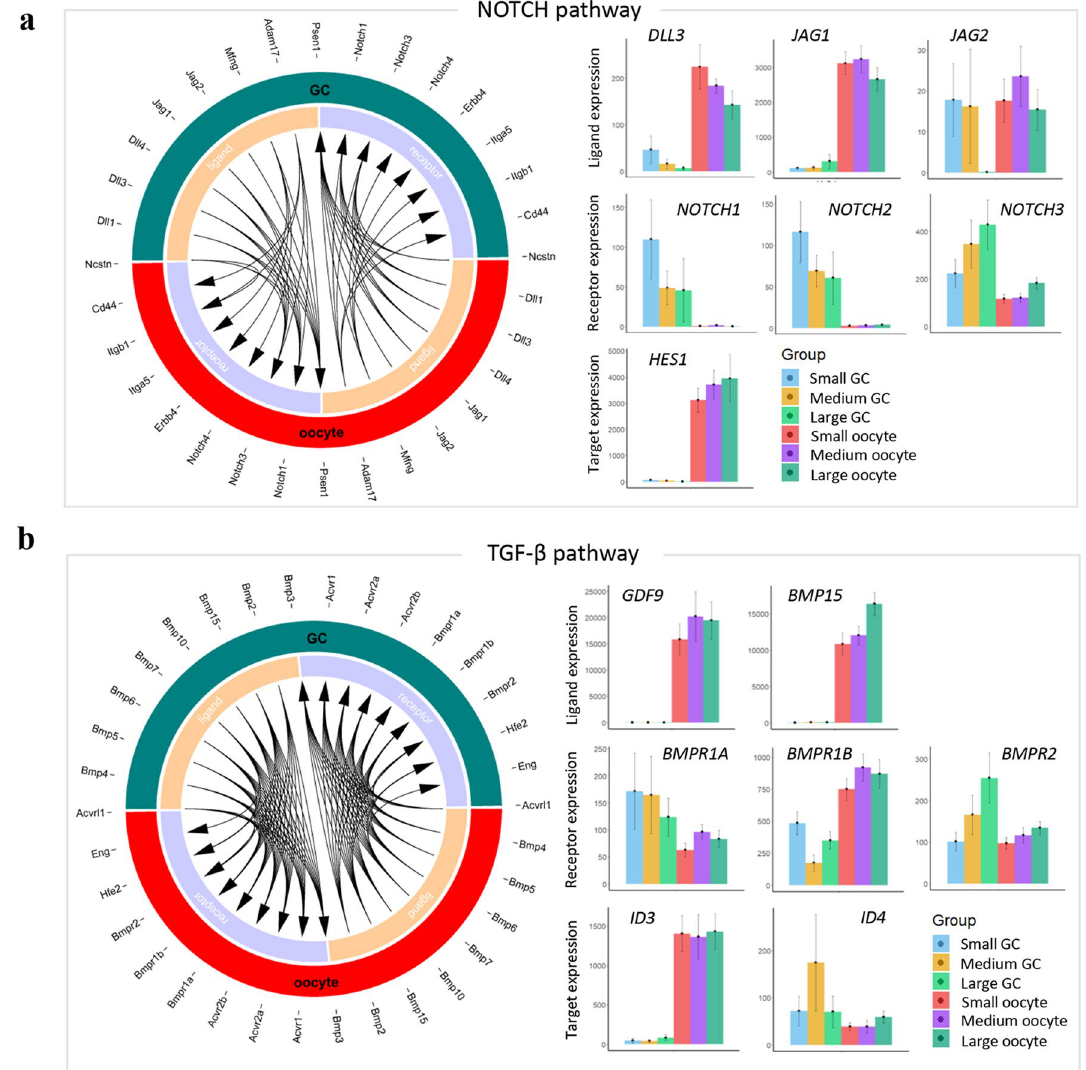
Figure 5. Ligand–receptor pairs in oocytes and GCs. ( a ) Ligand and receptor encoding genes in NOTCH pathway expressed in goat follicular oocyte and GCs. Left, outside circle showed in GC or oocyte; while inside circle showed ligands or receptors. Right, relative expression. ( b ) Ligand and receptor encoding genes in TGF-β pathway expressed in goat follicular oocyte and GCs. Left, outside circle showed in GC or oocyte; while inside circle showed ligands or receptors. Right, relative expression. Free R package Circlize (version0.4.11; https:// cran.r- proje ct. org/ web/ packa ges/ circl ize/) software was